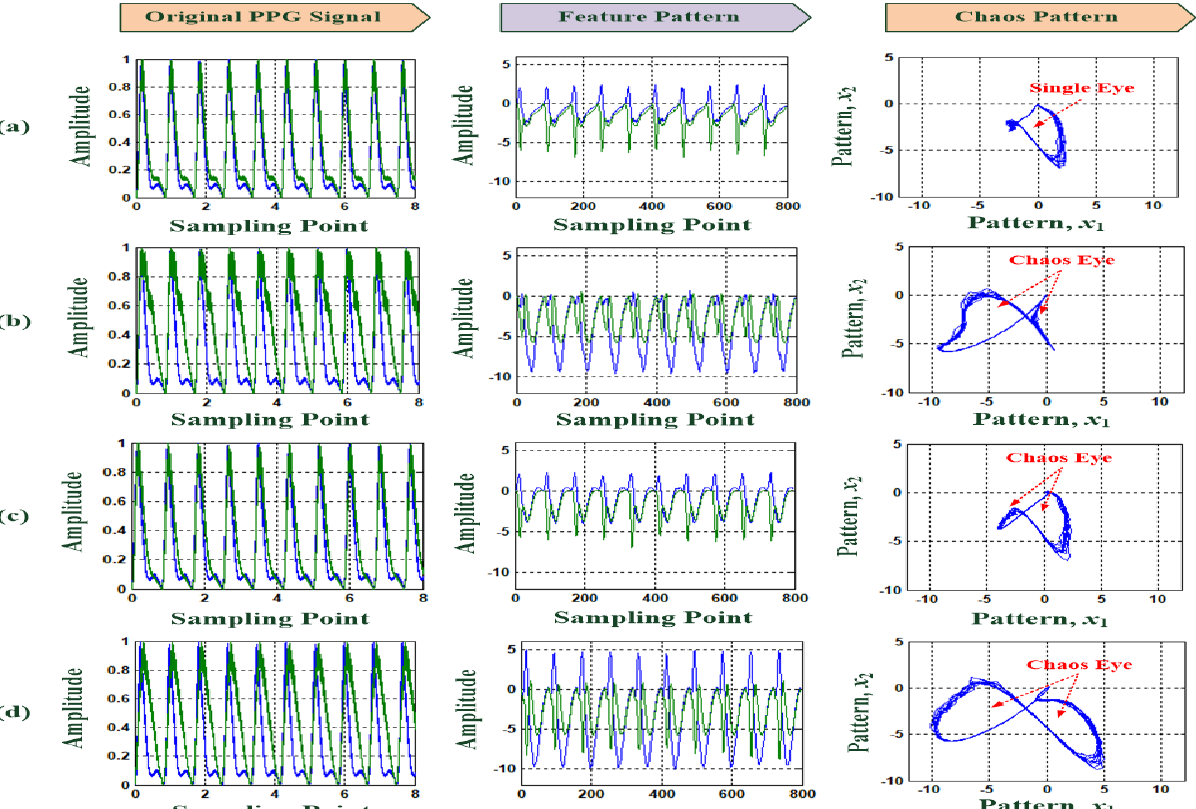
Figure 7. Original PPG signals (10 cycles), feature patterns (after the pooling processes), and chaos patterns for different PAD risk levels. ( a ) Nor: single eye in the chaos pattern, ( b ) and ( c ) LPAD cases, ( d ) HPAD case